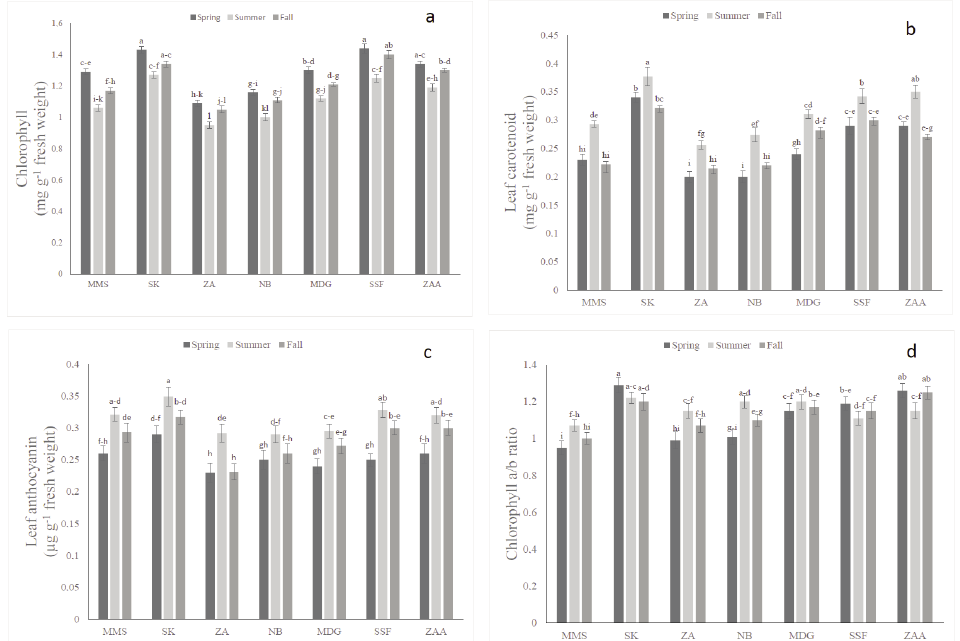
Fig. 4 ­ Seasonal changes in content of chlorophyll (a), carotenoid (b), anthocyanin (c), chlorophyll a/b ratio (d) in studied cultivars. Columns with different letters represent significant differences at 5% probability using Duncan’s multiple range test, those are valid for all